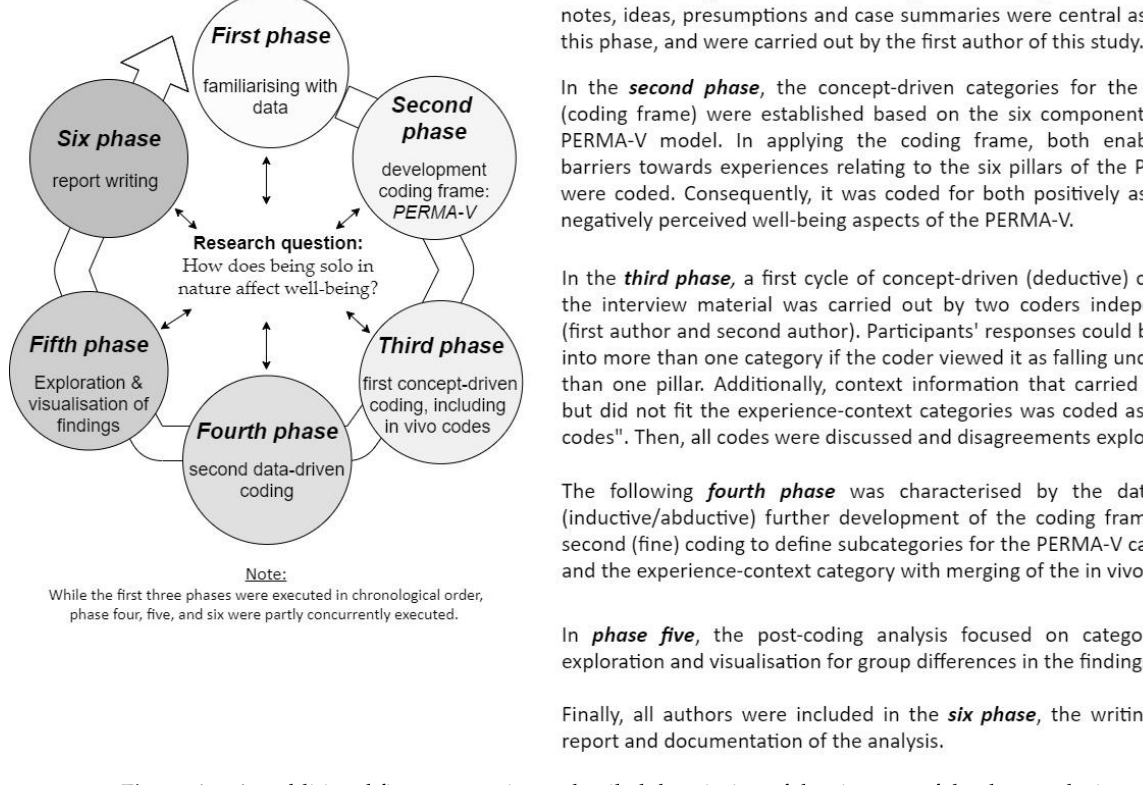
Figure A1. An additional figure comprises a detailed description of the six steps of the data analysis.